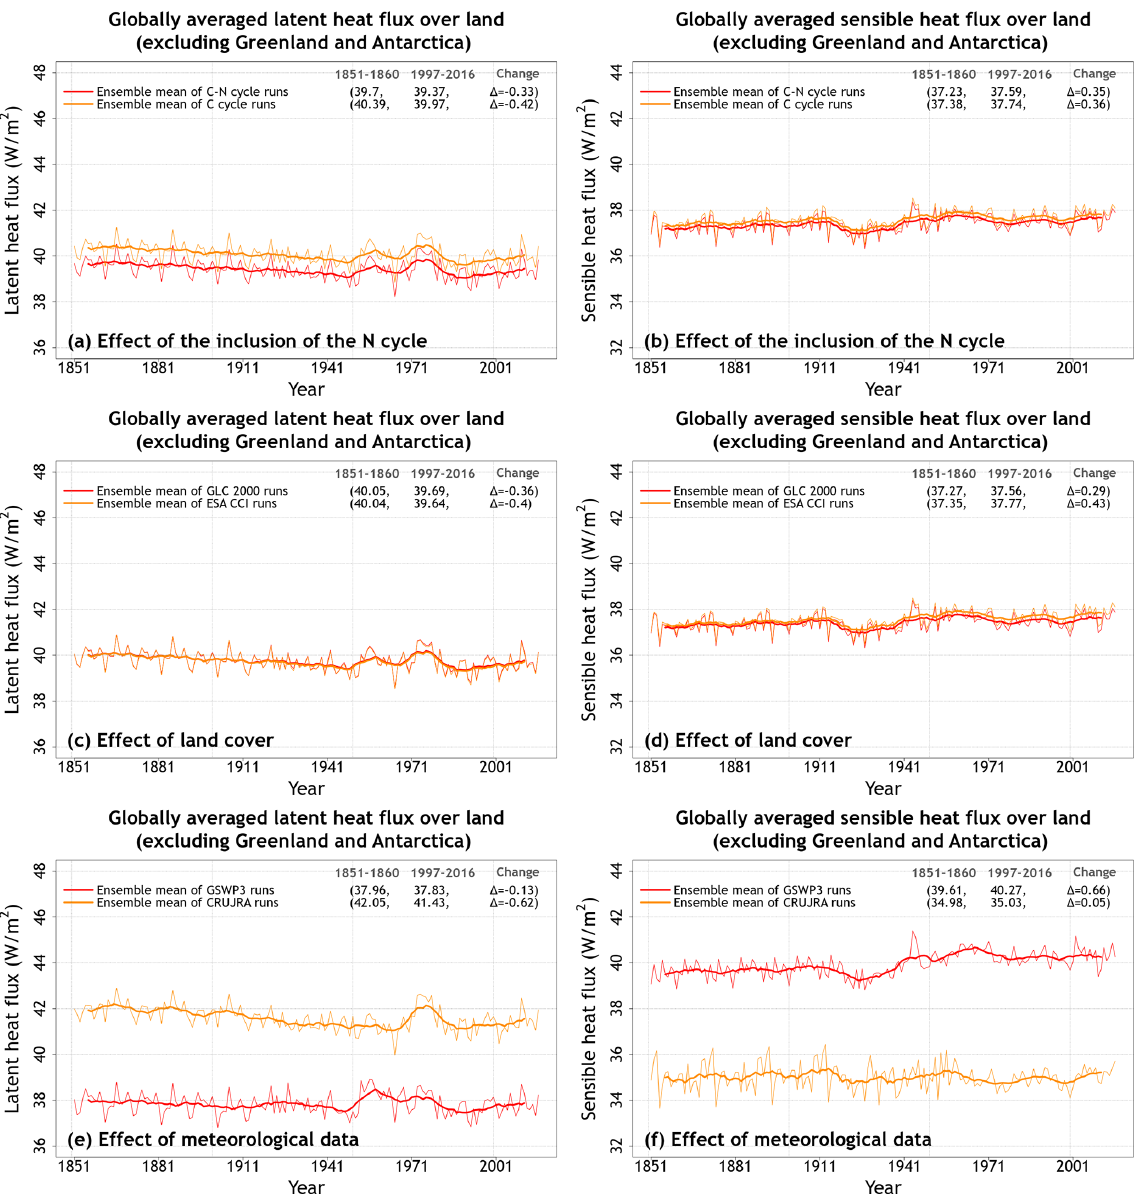
Figure 4. Time series of annual global latent and sensible heat fluxes (over all land area excluding Greenland and Antarctica) averaged over the four ensemble members that are driven with and without an interactive N cycle (a, b) , that are driven with the GLC-2000- and ESA- CCI-based land cover (c, d) , and that are driven with GSWP3 and CRU-JRA meteorological data (e, f) . The thin lines show the individual years, and the thick lines show their 11-year moving average. Model values averaged over the pre-industrial (1851–1860) and present-day (1997–2016) time periods, and their difference, for each ensemble averaged over its set of four simulations are also